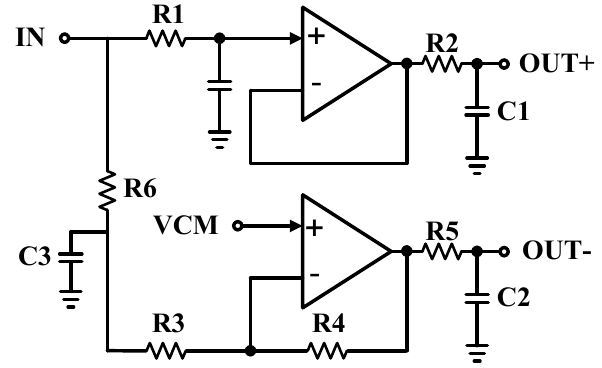
Figure 6. The schematic of the SDA of the system.